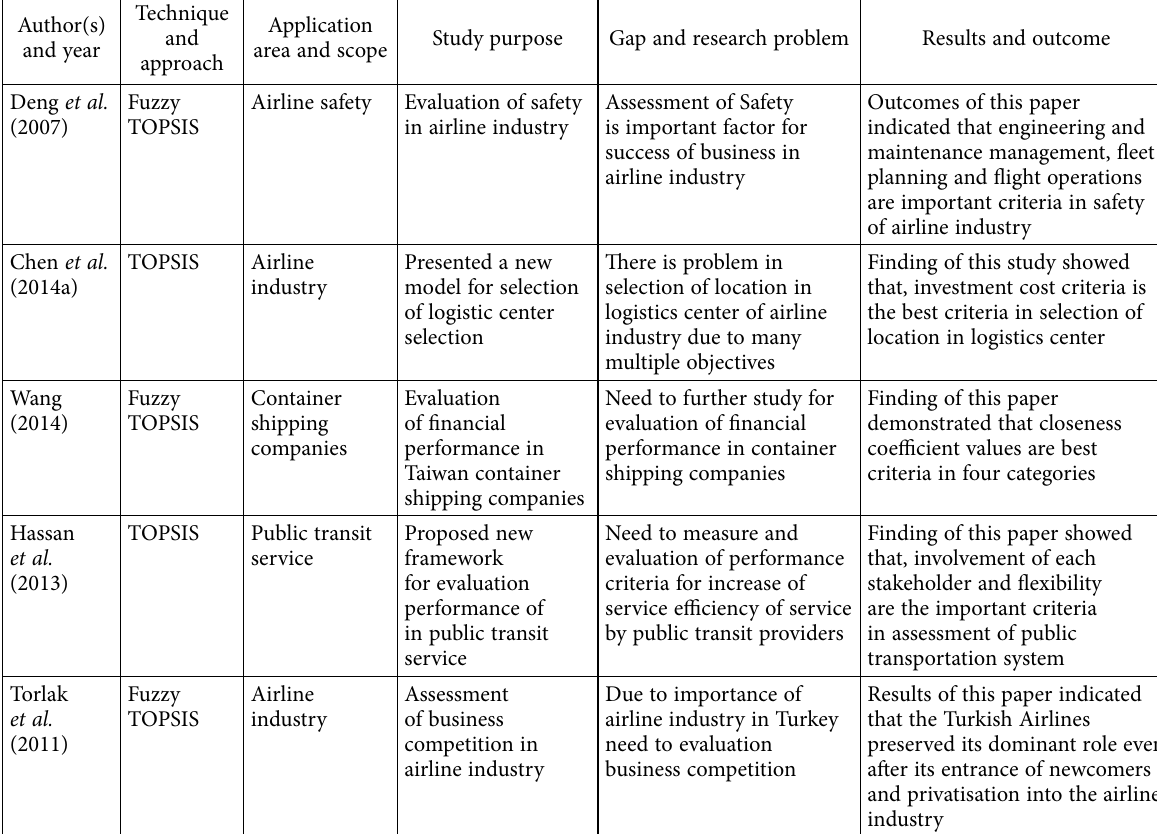
Table 6. Distribution based on TOPSIS and fuzzy TOPSIS with other